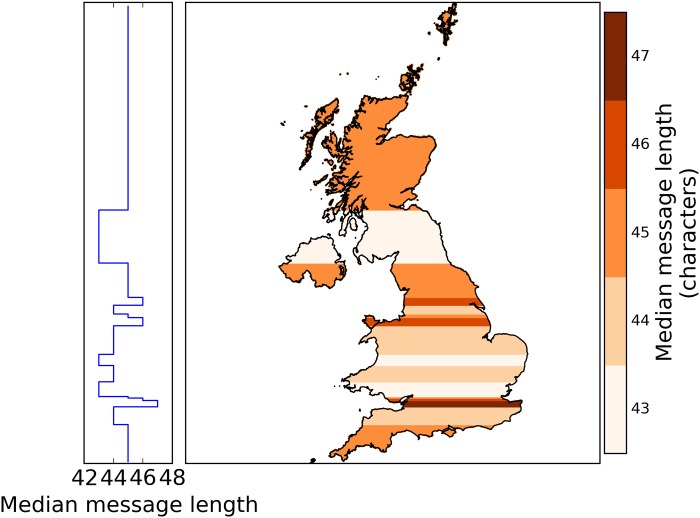
Median message length, in characters, by latitude.Partitioning the tweets into 20 latitude bins of about 105 tweets and 104 users each does not show any North-South division, however, the similarity of the Midlands and Southern Scotland becomes more prominent. Changing the number of bins does not result in drastic qualitative changes.